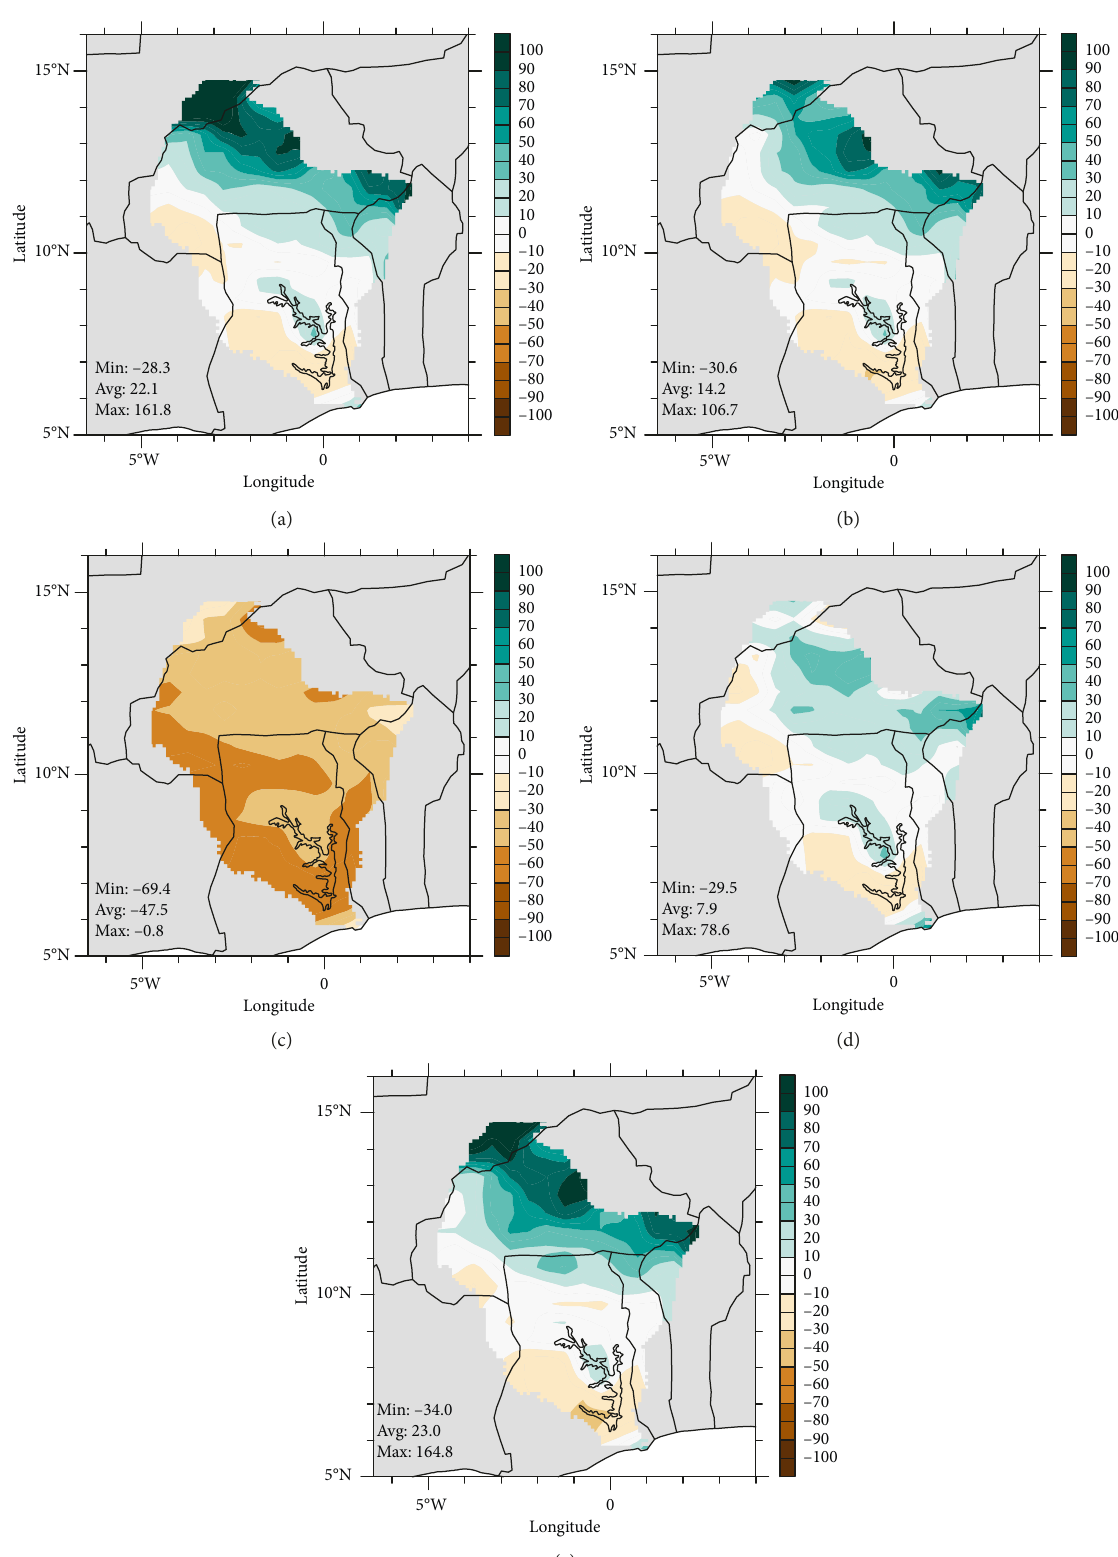
Figure 6: The climatological (1950–2004) mean bias in the seasonal totals of the models: CCSM4 (a), CESM1-BGC (b), MPI-ESM-MR (c), NorESM1-M (d), and ensemble mean (e), with least annual climatological mean biases for the dry season over the Volta